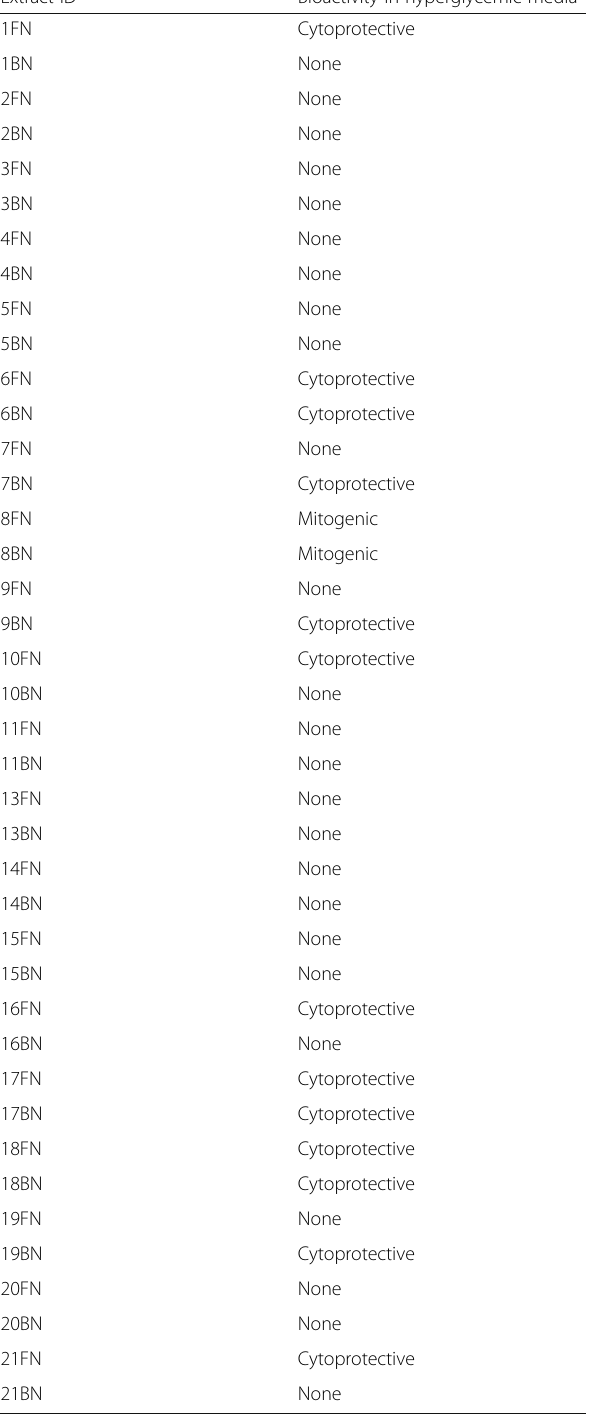
Table 1 Bioactivity of Picea mariana needle extracts in PC12-AC grown in hyperglycemic media Extract ID